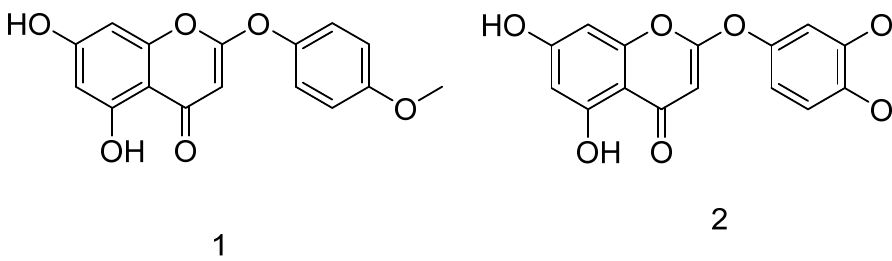
Figure 1. The chemical structures 6-demethoxy-4‘-O-capillarsine ( 1 ) and tenuflorin C ( 2 ).